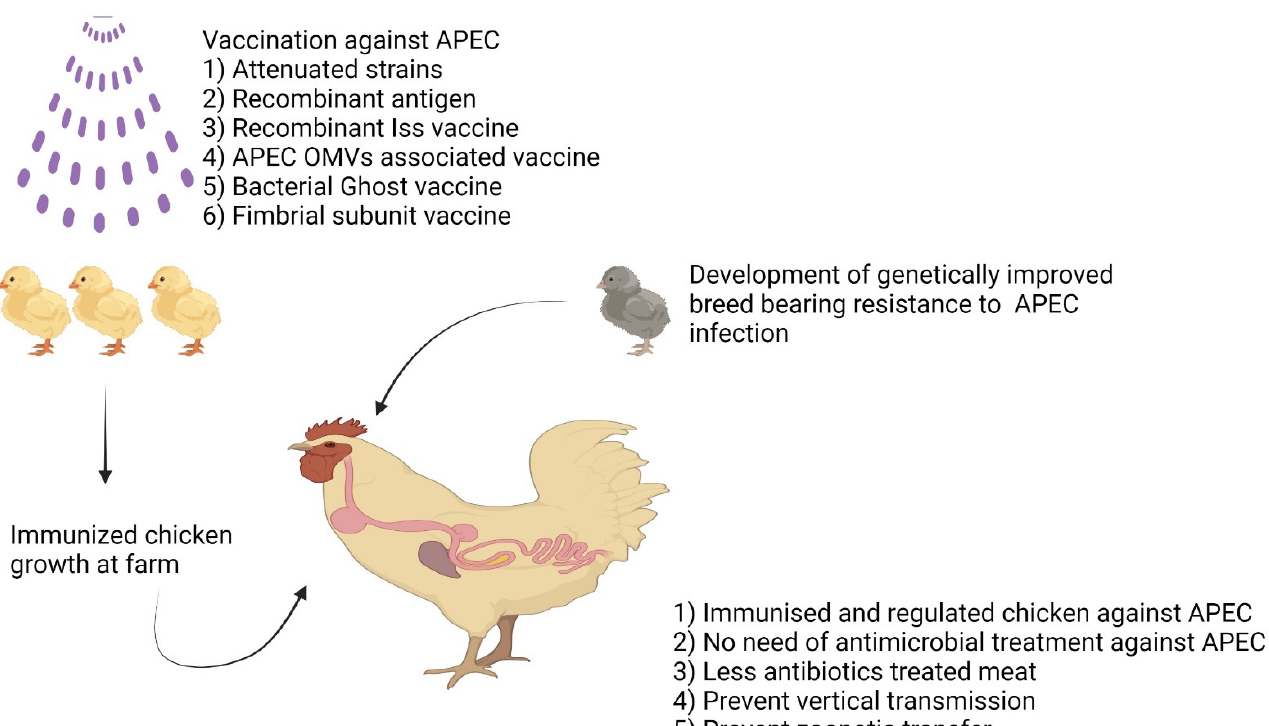
Figure 5. Vaccine development strategies against APEC. Different approaches used for vaccination against E. coli in poultry include live-attenuated vaccines (attenuation by chemical mutagenesis, or specific genetic modifications causing decreased virulence), inactivated or killed vaccines (whole bacterial cells killed by heat, chemicals such as formaldehyde, acetone, alcohol, irradiation, etc.), toxoids (toxins rendered innocuous by heating or formalin), or subunit-based vaccines (prepared from immunogenic epitopes of whole-cell proteins, outer membrane proteins, flagellin, fimbriae, lipopolysaccharides), and recombinant DNA technology (DNA vaccines, mRNA vaccines). These vaccines are normally administered by spray using coarse aerosol sprayer machine or mixed in drinking water free of chlorine or other sanitizing agents to one-day-old chickens or within the first week after hatching. The figure was created with BioRender.com (accessed on 22 January